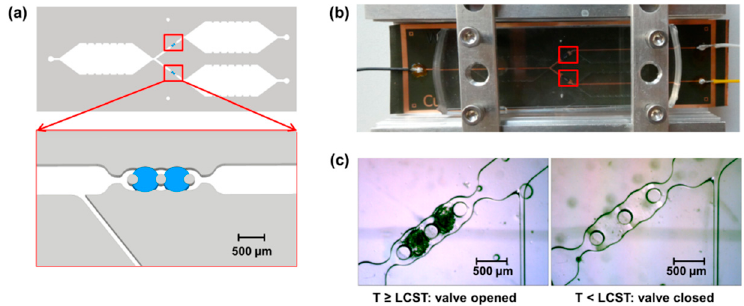
Figure 6. ( a ) Schematic design of the microfluidic device with three reaction chambers, two valves, and bypass channels in front of the valves. Each valve is formed by two hydrogel cylinders (blue) placed between the three in-line ordered PDMS pillars. ( b ) Photograph of a PDMS-on-glass microfluidic chip placed on a heat pad of PEI foil which is connected to a power supply and clamped in an aluminum frame. Red squares indicate the location of the valves which are placed above the two heat resistors of the heat pad. ( c ) Microscope images (10-fold magnification) of the hydrogel valves in the opened (shrunken) and closed (swollen) state. In the swollen state, the refractive index is similar to that of water and thus the contrast between hydrogel and fluid is low.